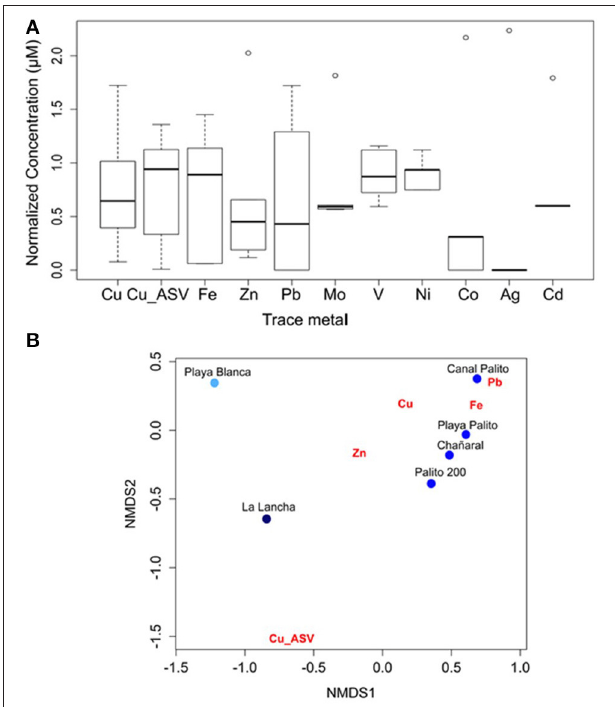
FIGURE 2 | (A) Boxplot for trace-metal concentration at the study sites. Values were log(x + 1) transformed and standardized. (B) Non-metric multidimensional scaling analysis according to metal concentrations that strongly varied between